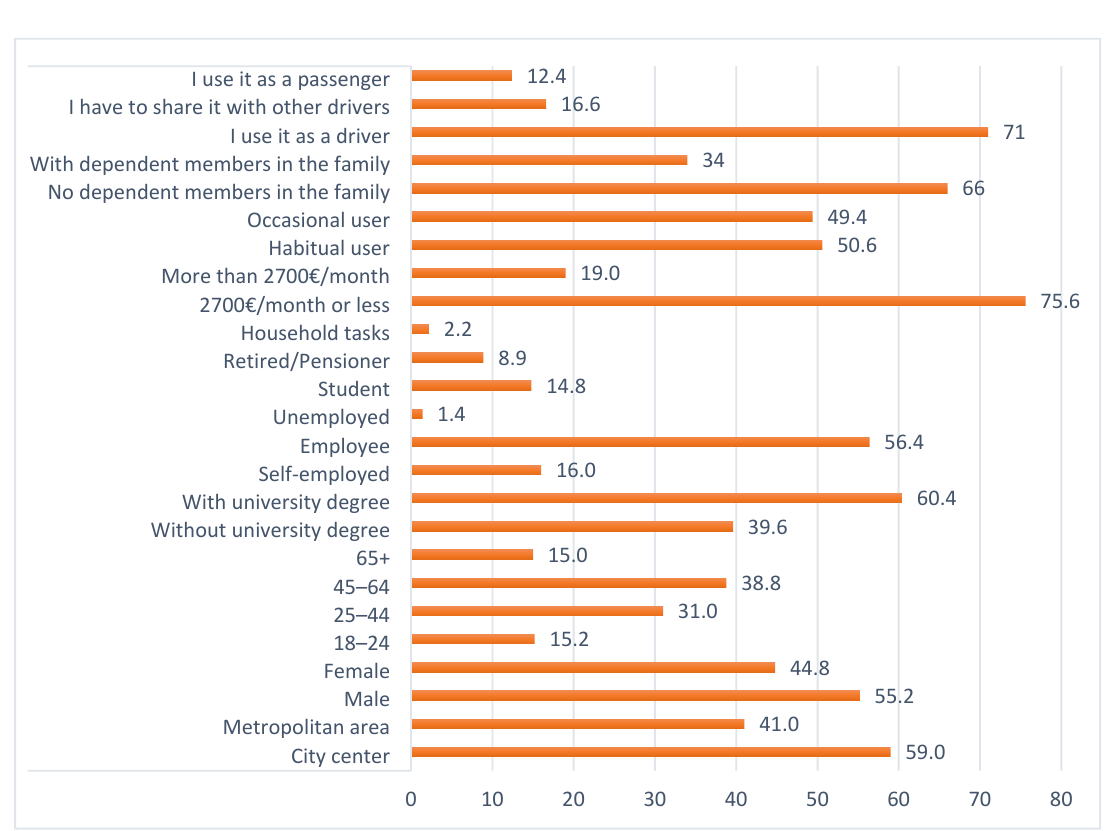
Figure 1. The sample description and characteristics of the survey.